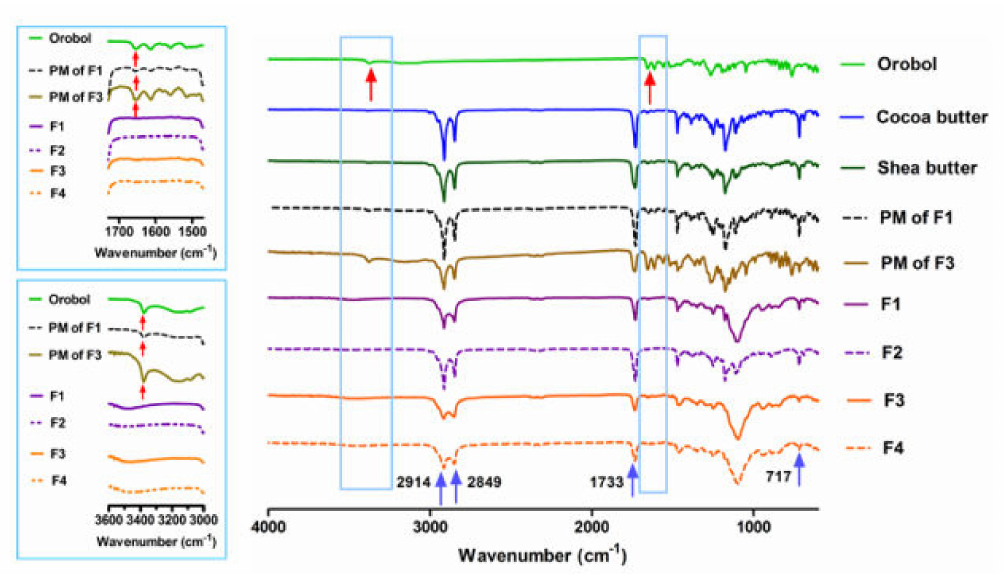
Figure 4. Fourier transform infrared (FTIR) analysis (relative intensity) of the orobol, solid lipids (i.e., cocoa butter and shea butter), PMs of F1 and F3, and lyophilized SLNs and NLCs formulations (F1 to F4). Distinctive bands of the orobol are presented at 1654 cm − 1 and 3378 cm − 1 (red arrows), while those of the lipids are presented at 717 cm − 1 , 1733 cm − 1 , 2849 cm − 1 , and 2914 cm − 1 (blue